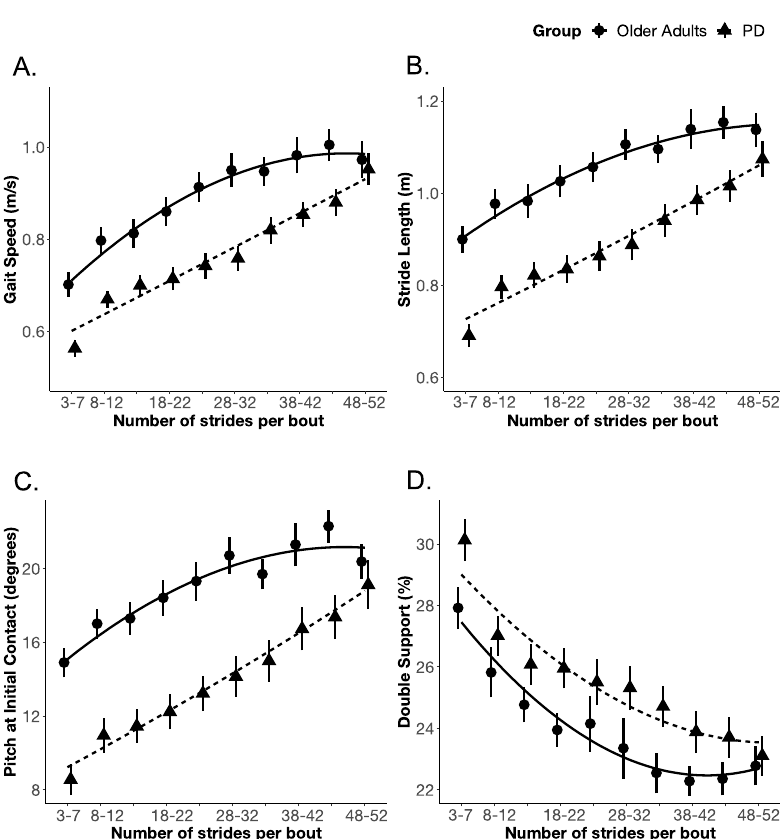
Figure 3. The growth curve analysis (PD vs. OA) model fit for ( A ) Gait speed, ( B ) Stride length, ( C ) Pitch at initial contact, and ( D ) Double-support.